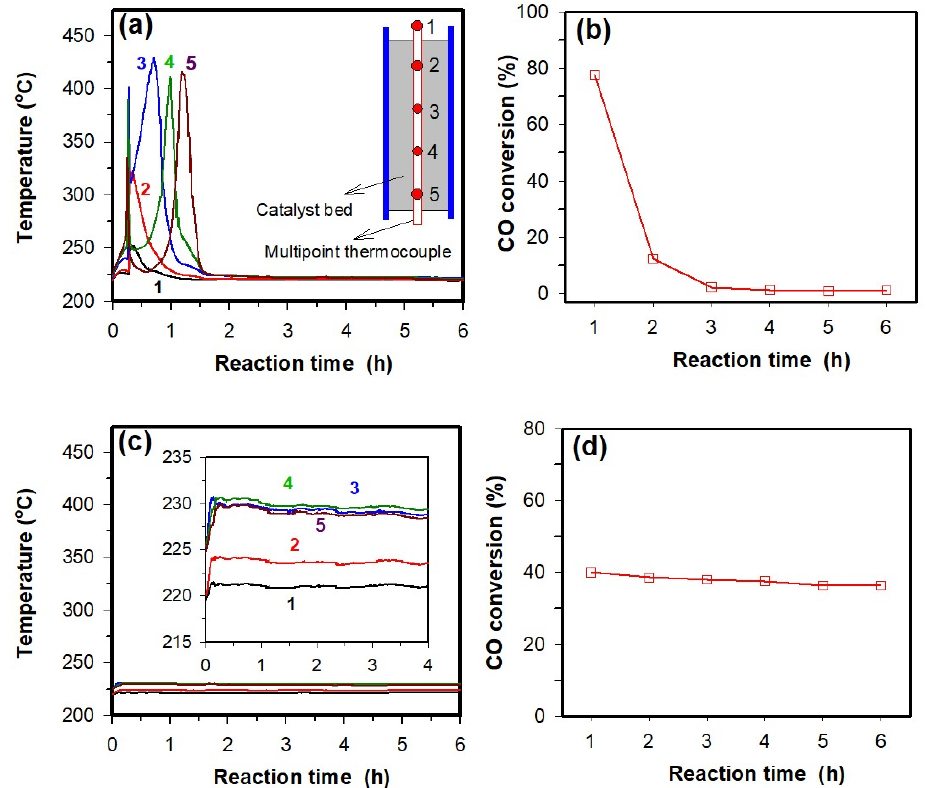
Figure 13. Temperature profiles at the centerline of the packed beds of PCM-absent ( a ) and PCM-present ( c ) Co/SiO 2 catalysts measured by a multi-point thermocouple (locations of thermocouple no. 1–5 are shown in the inset) and CO conversion as a function of reaction time over PCM-absent ( b ) and PCM-present ( d ) Co/SiO 2 catalysts. Inset in ( c ) is a magnified version of the plot of temperature vs. reaction time (from 0 to 4 h).